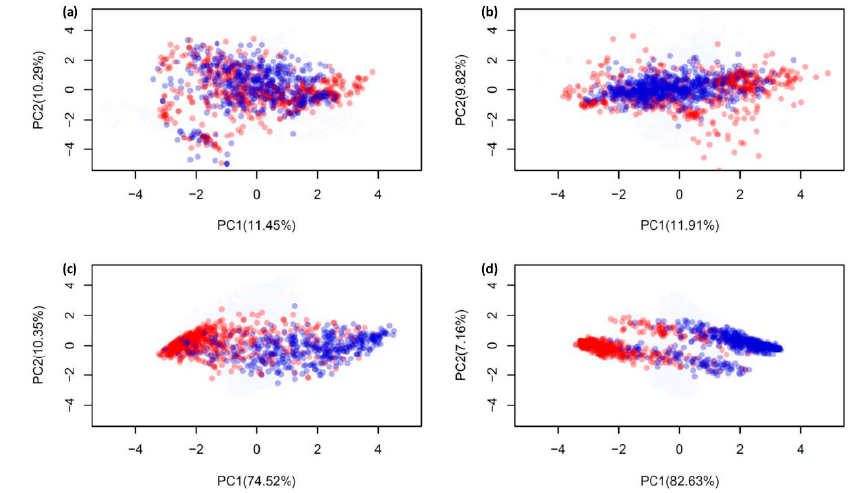
Figure 6. Principle component analysis (PCA) scores plot of the distribution of AVPs and Non-AVPs, where AVPs and Non-AVPs are represented by red and blue circles, respectively. ( a ) and ( c ) represent the distribution of amino acid composition and a new feature representation, respectively, obtained from the dataset T 544p + 407n + V 60p + 45n , while ( b ) and ( d ) represent the distribution of pseudo amino acid composition and a new feature representation, respectively, obtained from the dataset T 544p + 544n + V 60p + 60n